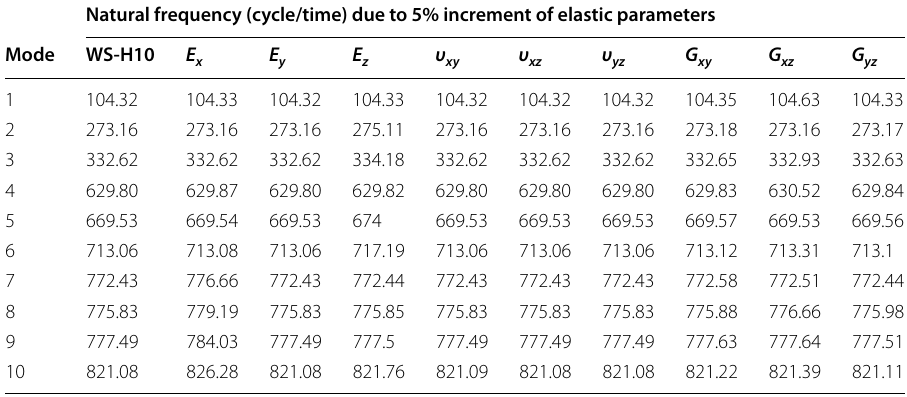
Sensitivity analysis for the sandwich composite plate with holes in core layers w.r.t elastic parameters